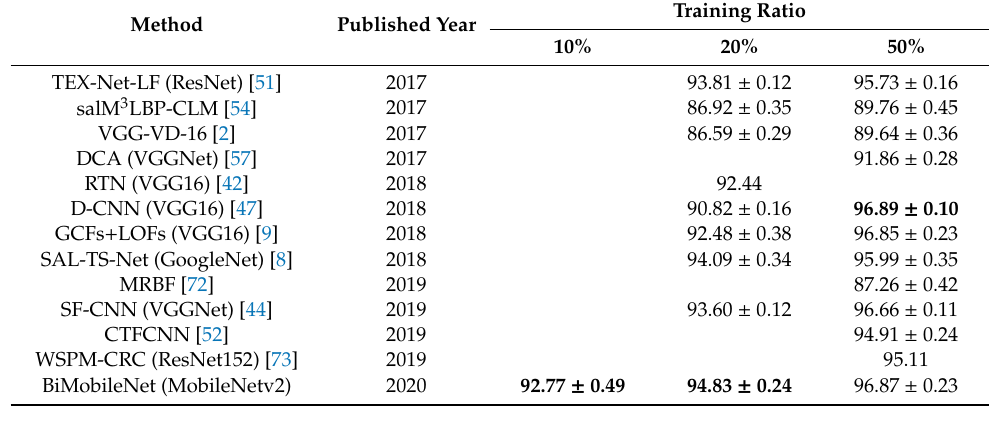
Table 5. Overall accuracy of the state-of-the-art methods on AID dataset. The highest accuracy for each ratio is bolded.